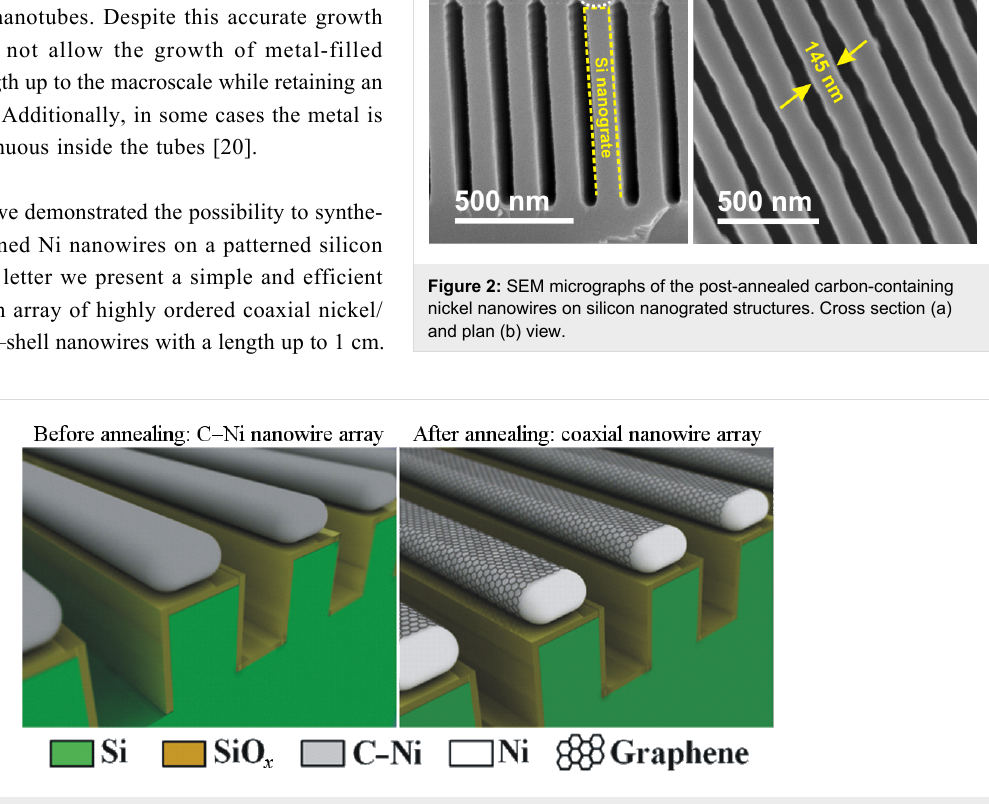
Figure 1: Schematics of the carbon-containing nickel nanowire array before (left) and after (right) post-annealing for 1 h at 400 °C.